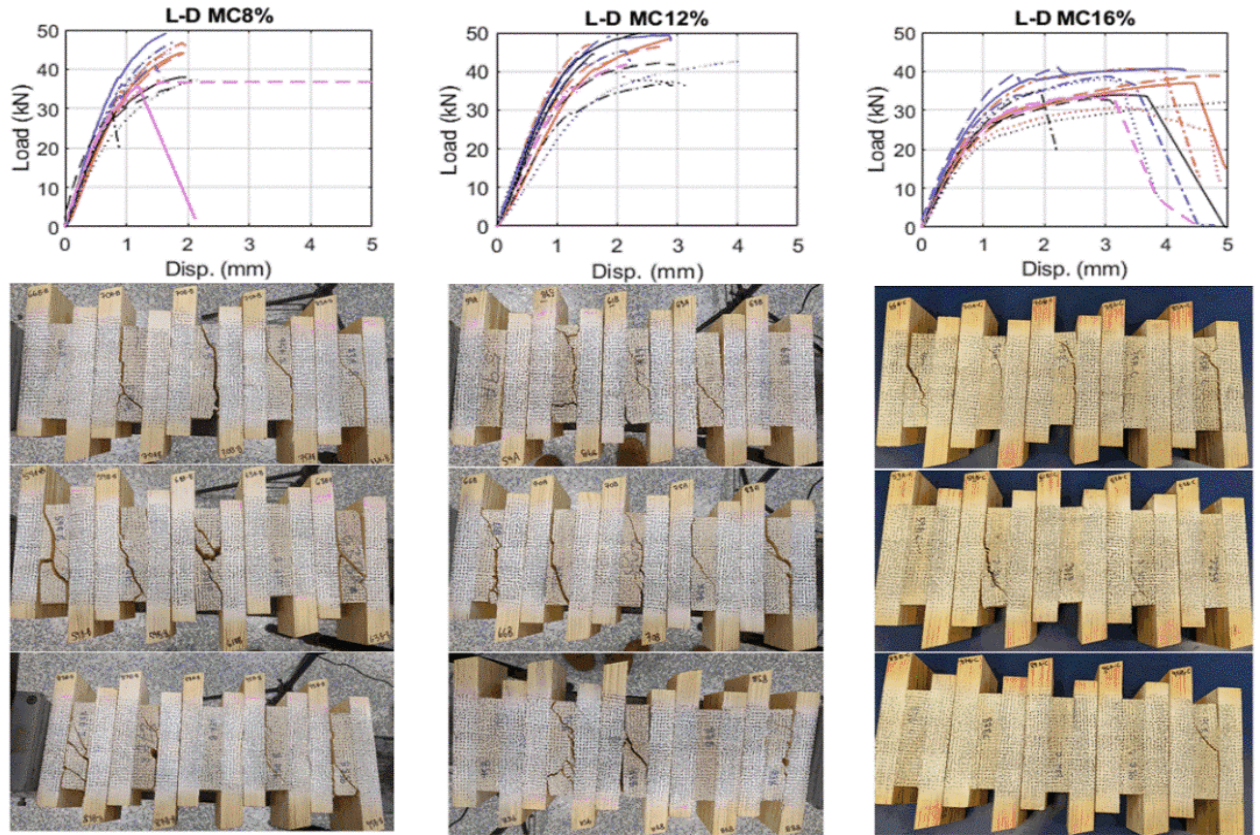
Figure 6. Load vs. displacement curves for all tested samples, and relevant failure modes of the samples subjected to various moisture contents.